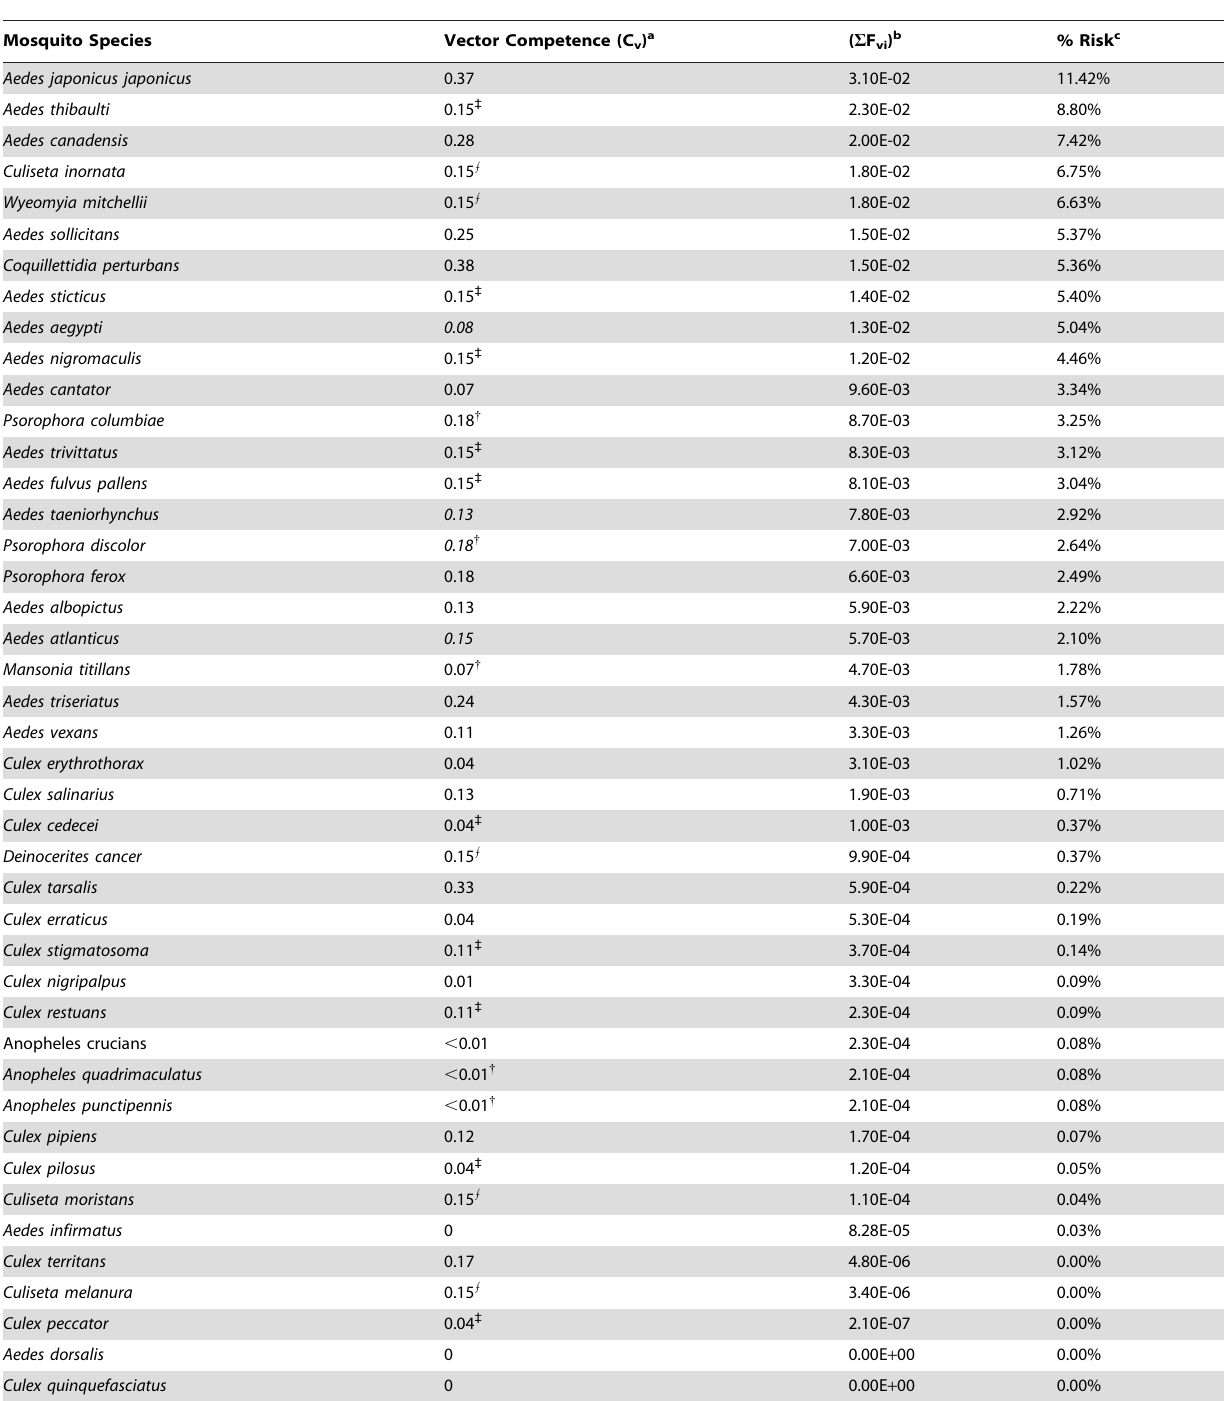
Table 2. Relative risk of mosquitoes contributing to Rift Valley fever enzootic transmission in the